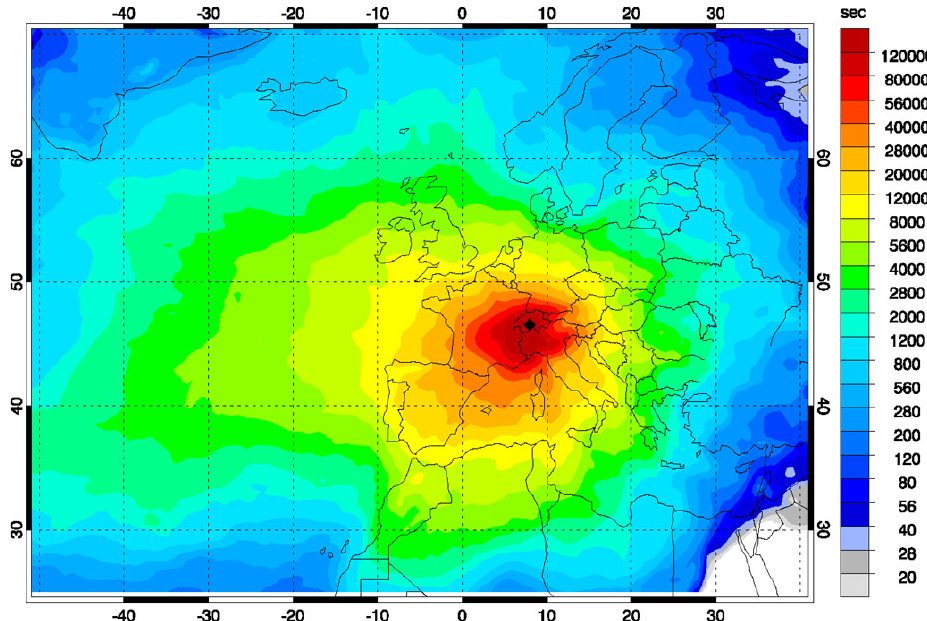
Fig. 2. Total footprint of all air masses sampled at Jungfraujoch during the investigation period (2005–2009): colour contours represent residence times of air parcels within a specific geographic grid cell relative to the maximum residence time. The maximum residence time corresponds to the end point of all trajectories, i.e. to Jungfraujoch. The lower panels show the number of trajectories per month (on the left) and per hour of the day (on the right) used to create the footprint map. Since trajectories were only calculated for valid observations, these panels demonstrate the rather uniform sampling of CO 2 over the different months of the year and hours of the day.